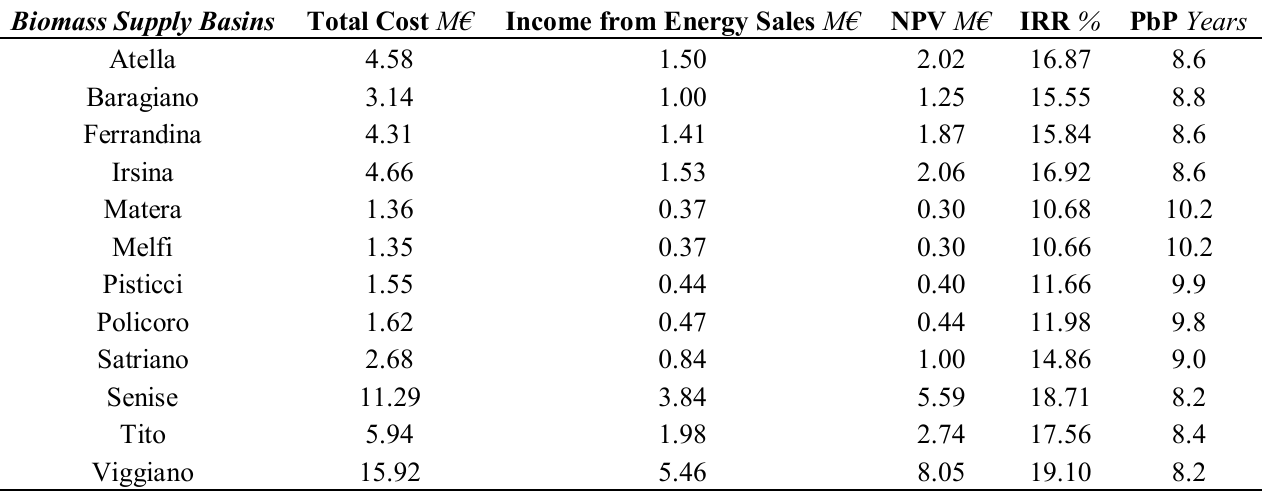
Table 8. Net present value (NPV), internal rate of return (IRR) and Payback Period ( Million €